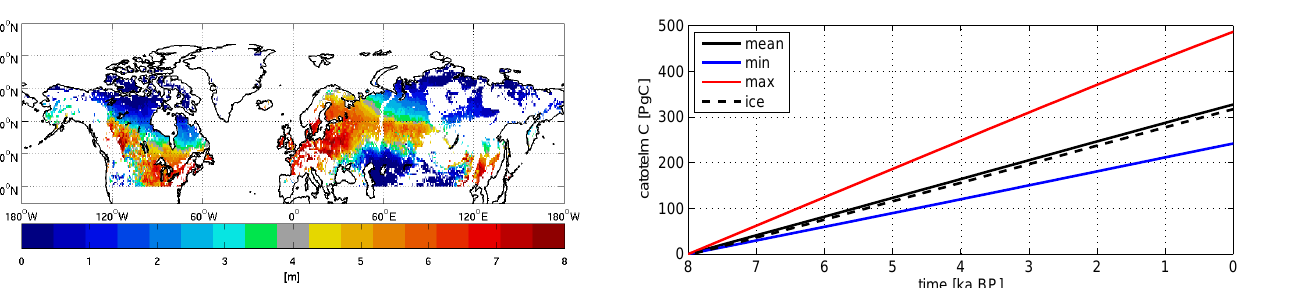
landfra tion),a umulatedoverthelast8ka.